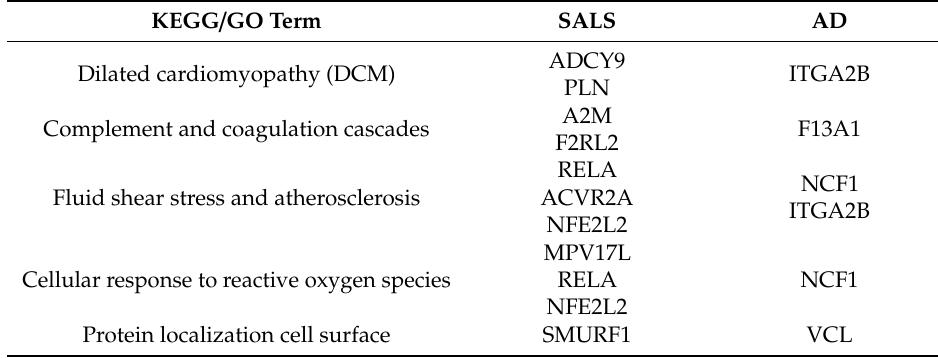
Table 2. Shared enriched KEGG or GO terms among SALS and AD patients. In the first column the term is reported; in the columns relative to each disease the genes with the highest fold change involved in each term are reported, in green those up-regulated, in red those